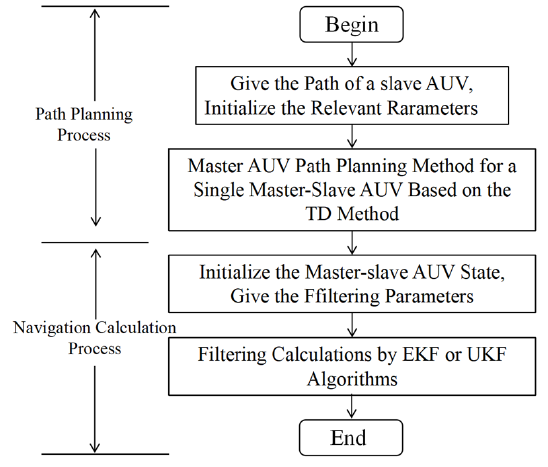
Figure 11. Multi-AUV cooperative navigation method flow.